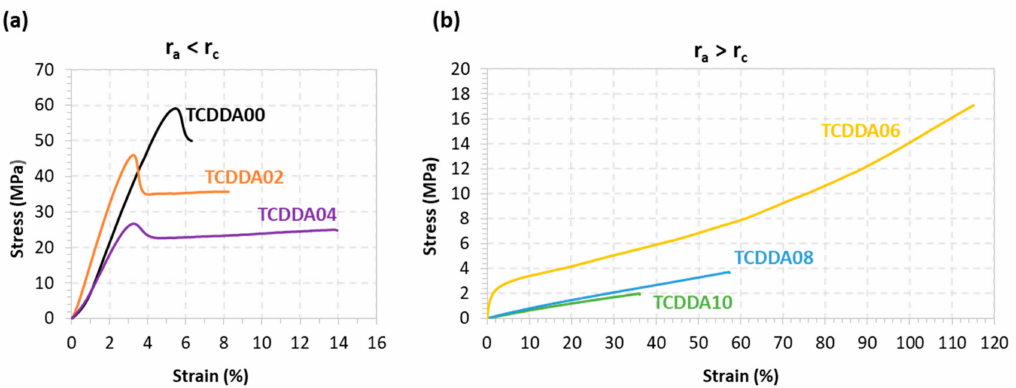
Figure 5. Stress-strain curves from tensile tests on final materials: ( a ) r a < r c ; ( b ) r a > r c . Table 3. Characteristic mechanical parameters obtained from tensile test and hardness measurements. Coe ffi cients of variation less than 10% for stress, strain and tensile modulus, and less than 5% for Shore-D